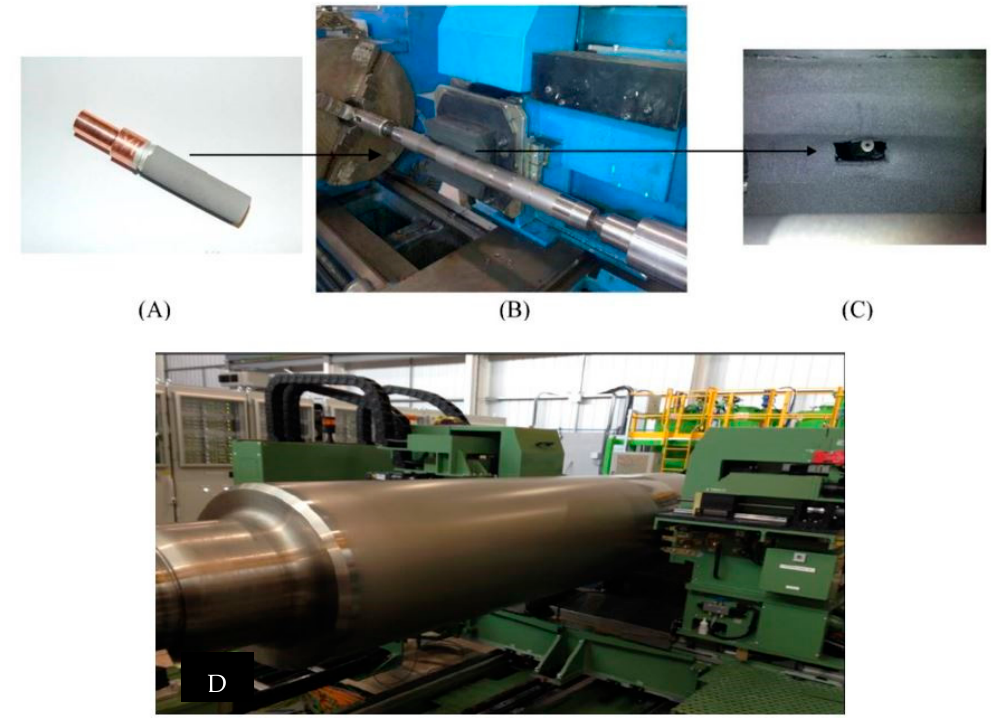
Figure 24. ( A – C ) EDC surface bands on A2 steel and ( D ) EDC over temper mill roll